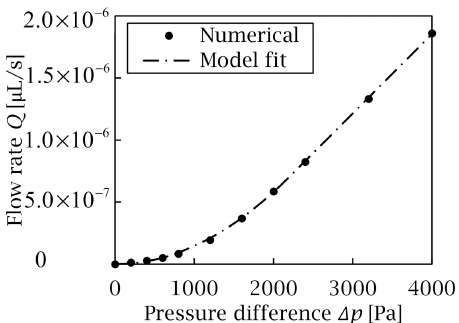
Figure 8. Relationship between flow rate and pressure difference for Bingham fluid flow by simula- tion. The sample size is N = 100 and resolution ratio is R = 1.0. The proposed model (dashed line) matches the simulation results (dot) well. The flow rate changes from a parabolic form to a linear form when the pressure difference increases.